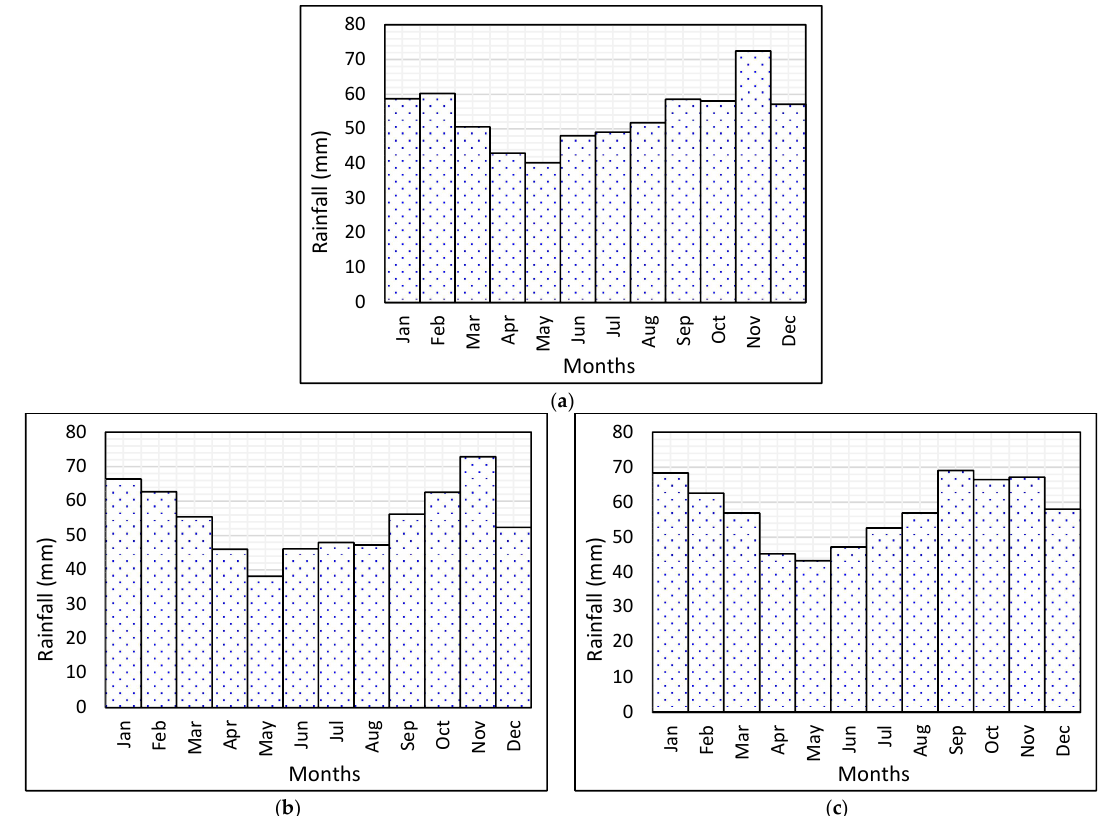
Figure 2. Monthly variations of rainfalls for the selected stations throughout the study period. ( a ) Ainslie Tyson St; ( b ) Tharwa General Store; ( c ) Huntly.